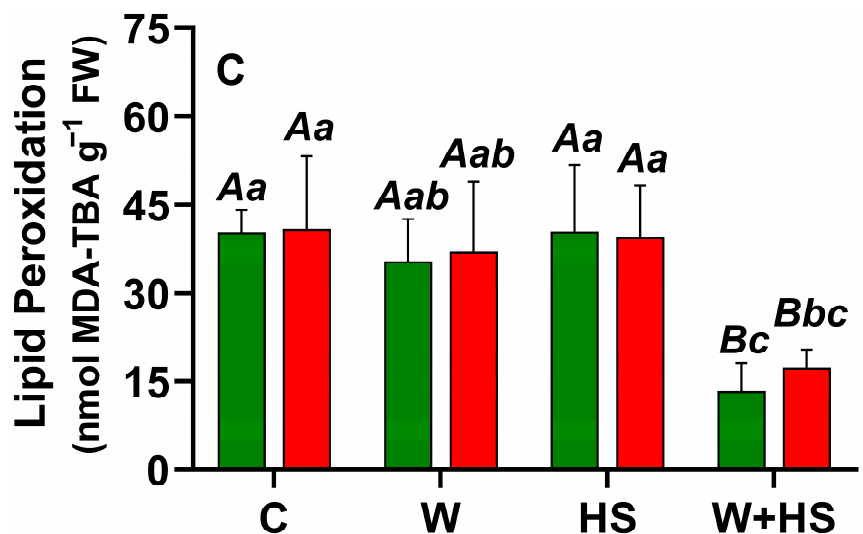
Figure 1. Hydrogen peroxide ( A ), superoxide ( B ), and lipid peroxidation ( C ) of local and systemic leaves submitted to different treatments. Capital letters represent differences between the treatment factor by the post hoc Tukey test, an asterisk next to the indicating letter in the figure indicates inter- action between the factors through two-way ANOVA, and lowercase letters indicate the differences found by the Tukey test for the interaction between the factors of treatments and fabrics. C = control; W = wounding; HS = heat shock; W+HS = wounding + heat shock. p ≤ 0.05; n =